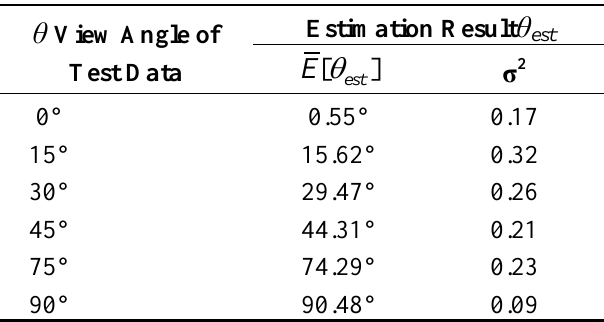
Table 1. Gait view angle estimation